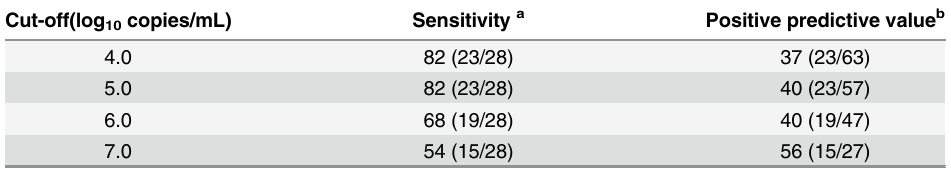
Table 4. Sensitivities and positive predictive values for detection of severe pneumococcal pneumonia (Pneumonia Severity Index risk class IV-V) at different nasopharyngeal DNA density cut-off levels. Cut-off(log 10 copies/mL)